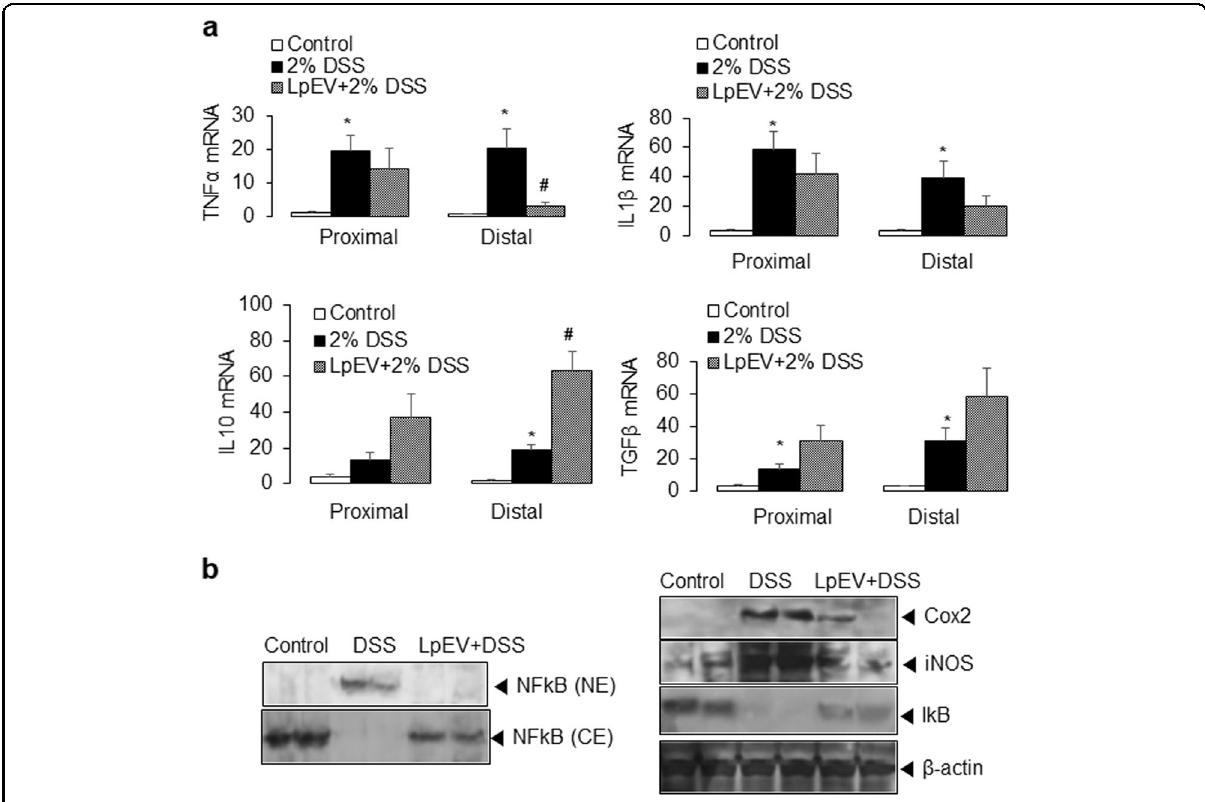
Fig. 5 Effect of LpEVs on the expression of in fl ammatory cytokines and mediators in a DSS-induced colitis mouse model. a The mRNA levels of cytokines (TNF α , IL-1 β , IL-10, and TGF β ) were analyzed using qRT-PCR. b The protein expression of COX-2, iNOS, nuclear NF κ B and I κ B, and cytosolic NF κ B and I κ B were analyzed using western blot analysis. * P < 0.05 compared with the drinking water-treated control mice. The results are expressed as the mean±standard deviation of six mice. # P < 0.05 compared with the 2% DSS-treated mice without